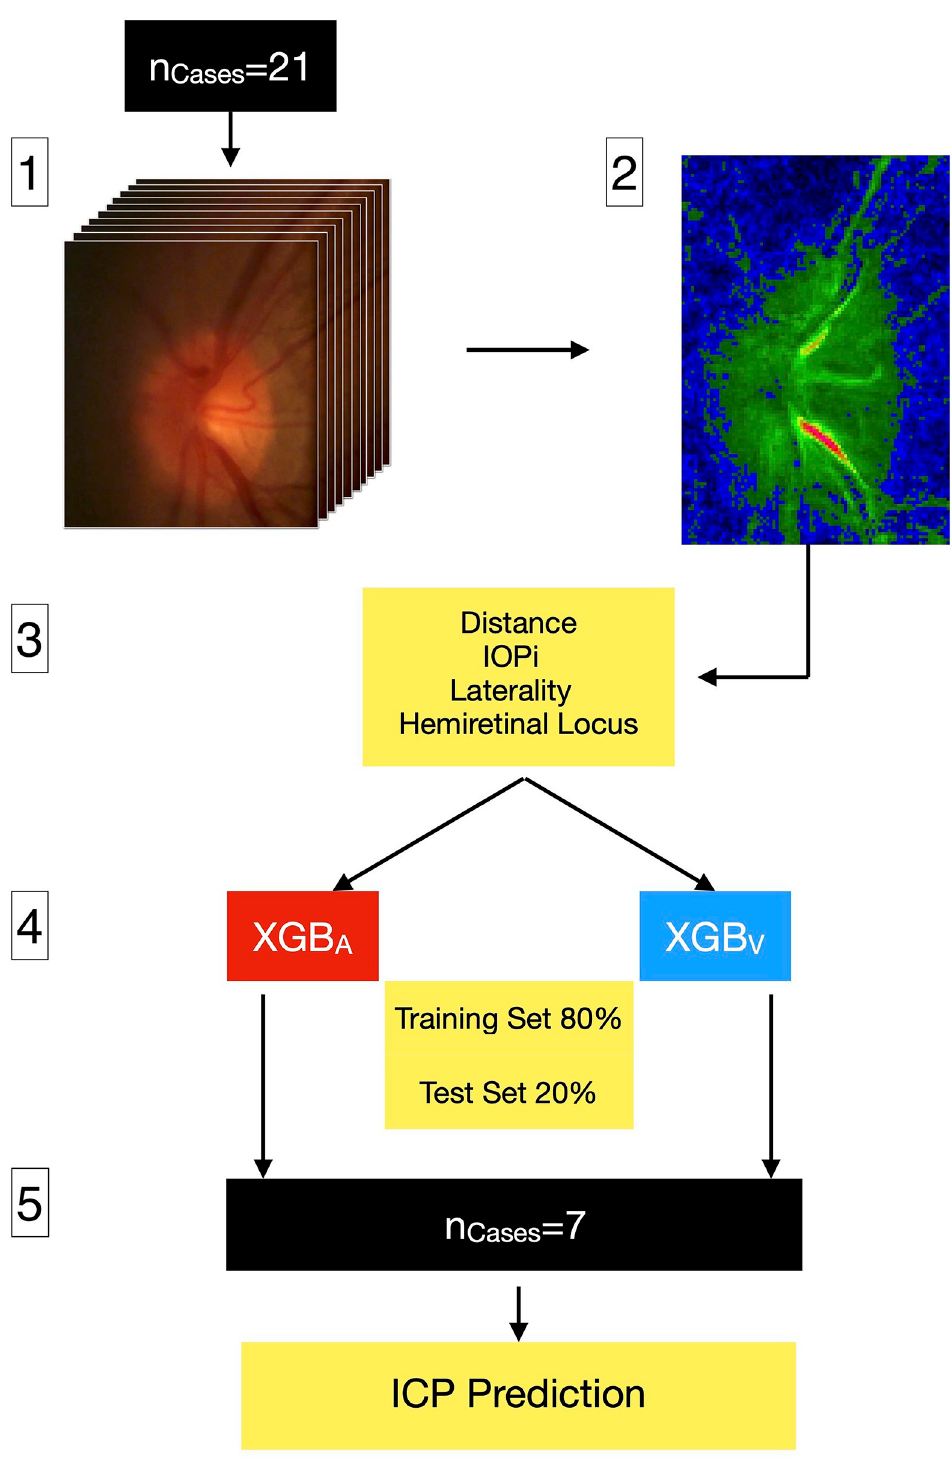
Fig 3. Flow chart of image processing, analysis, and XGB model application. 1) Alignment and segmentation of image frames from a video sequence spanning three consecutive cardiac cycles captured from 21 subjects using Modified Photoplethysmography. 2) Image analysis was performed by fitting a harmonic regression model to each pixel cluster. The periodic component was represented by the first two harmonics of a Fourier series. 3) The Fourier coefficients, harmonic regression amplitude, together with the distance along the vessel, induced intraocular pressure